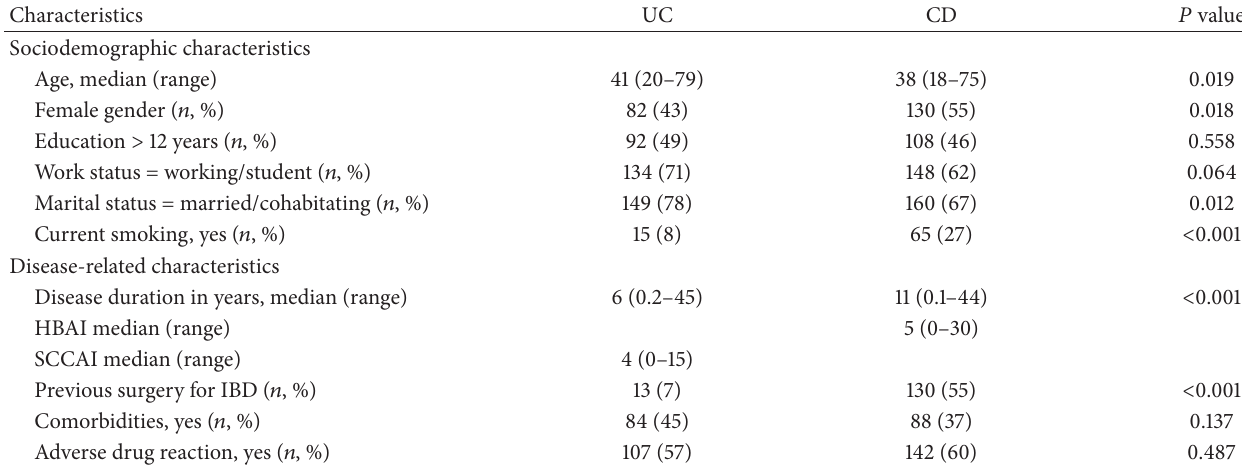
Table 1: Characteristics of patients with ulcerative colitis ( 𝑛 = 190 ) and Crohn’s disease ( 𝑛 = 238 ). Characteristics